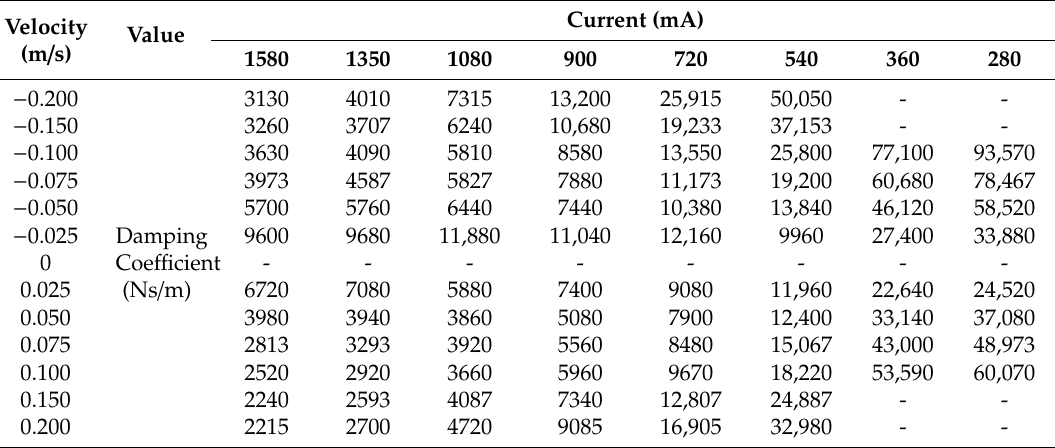
Table 6. Results of damping coe ffi cient for